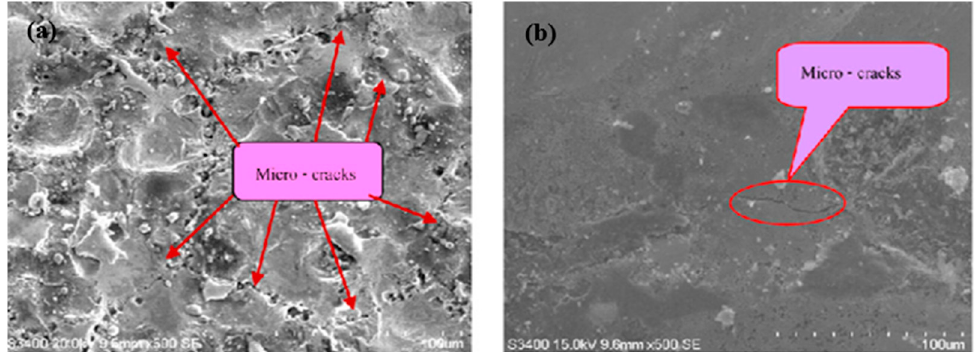
Figure 13. SEM images that represent the surfaces of tungsten carbide produced by ( a ) EDM and ( b ) EDC [87]. (With kind permission from Elsevier). ( b ) EDC [87]. (With kind permission from